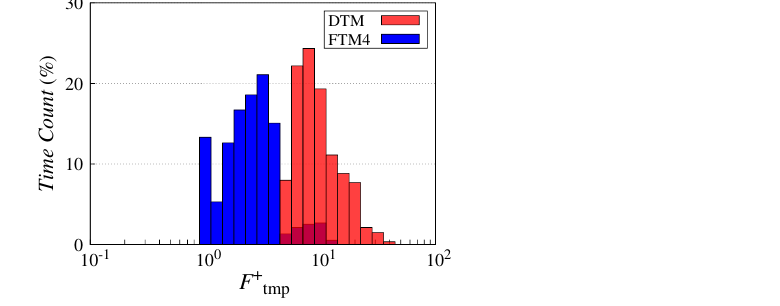
) histograms in the DTM and FTM4 at α = tmp